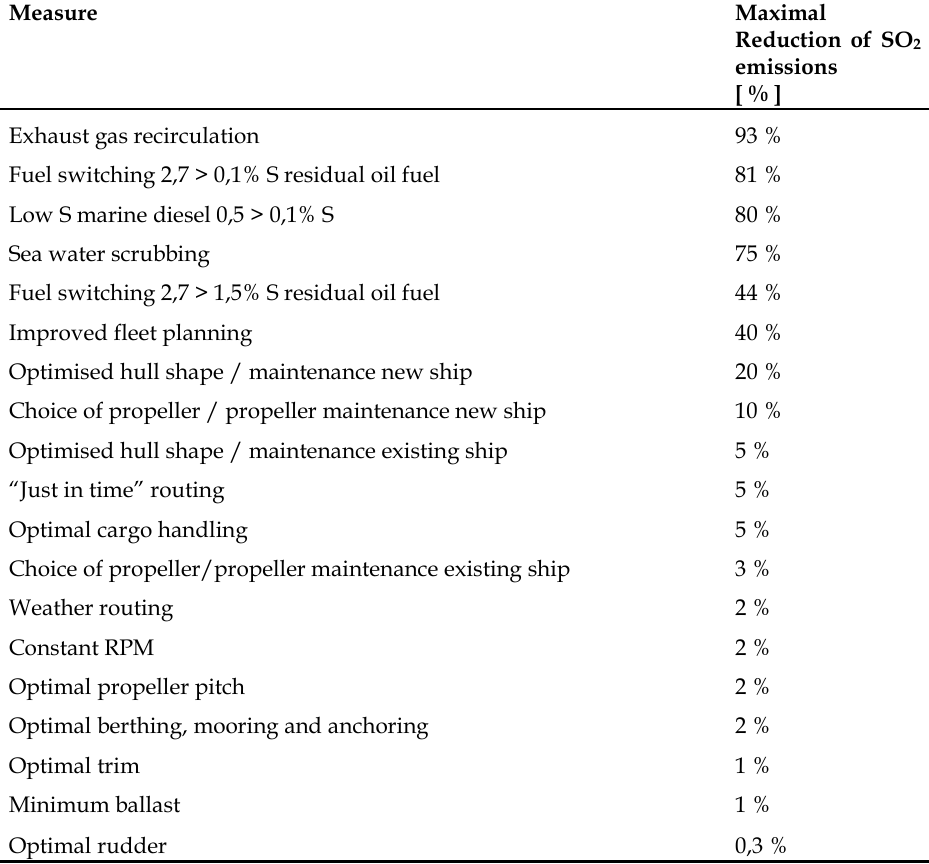
Table 3. Emission control technologies and their reduction efficiencies (Cofala 2007, Martinek